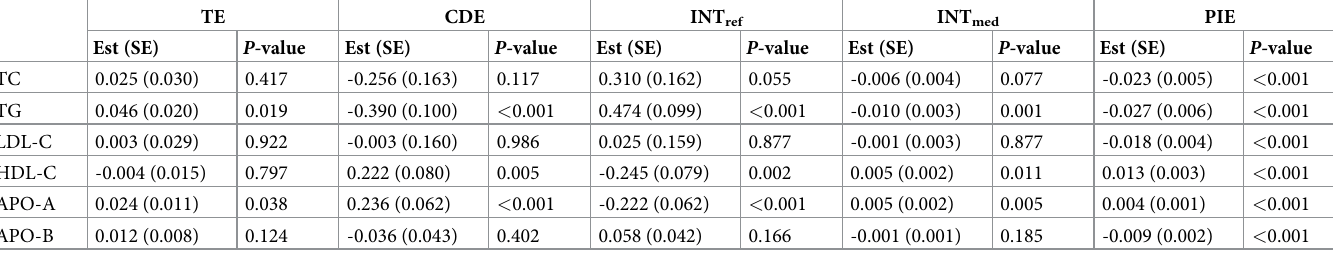
Table 2. Decomposition of the effect of smoking on lipid profiles due to mediation and interaction with BMI.